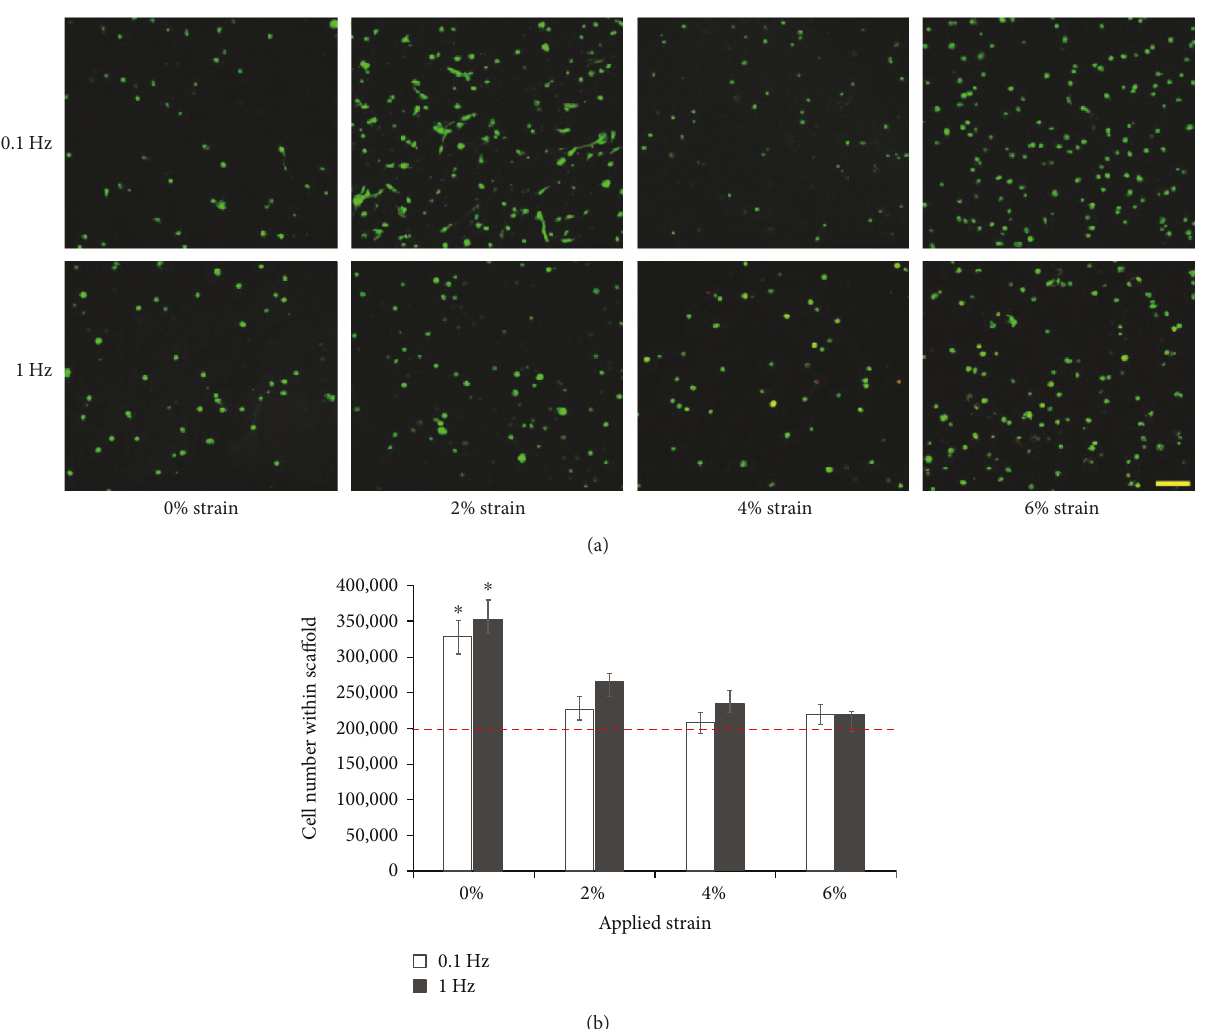
Figure 1: E ff ect of uniaxial tensile loading on ASC viability and proliferation within 3D collagen sca ff olds. (a) Confocal images of ASC-seeded collagen constructs subjected to 7 days of uniaxial loading at 0%, 2%, 4%, and 6% strains and 0.1Hz and 1Hz frequencies. Green represents live cells and dead cells are stained red. Scale bar represents 100 μ m. Cells are viable within the loaded collagen sca ff olds. (b) Quanti fi cation of cell number within sca ff olds by estimating the DNA content. Red dotted line indicates the initial cell number in each sample. ∗ represents the statistical di ff erence from the other groups. Cells subjected to mechanical stimulation remain viable but show limited proliferation when compared to control